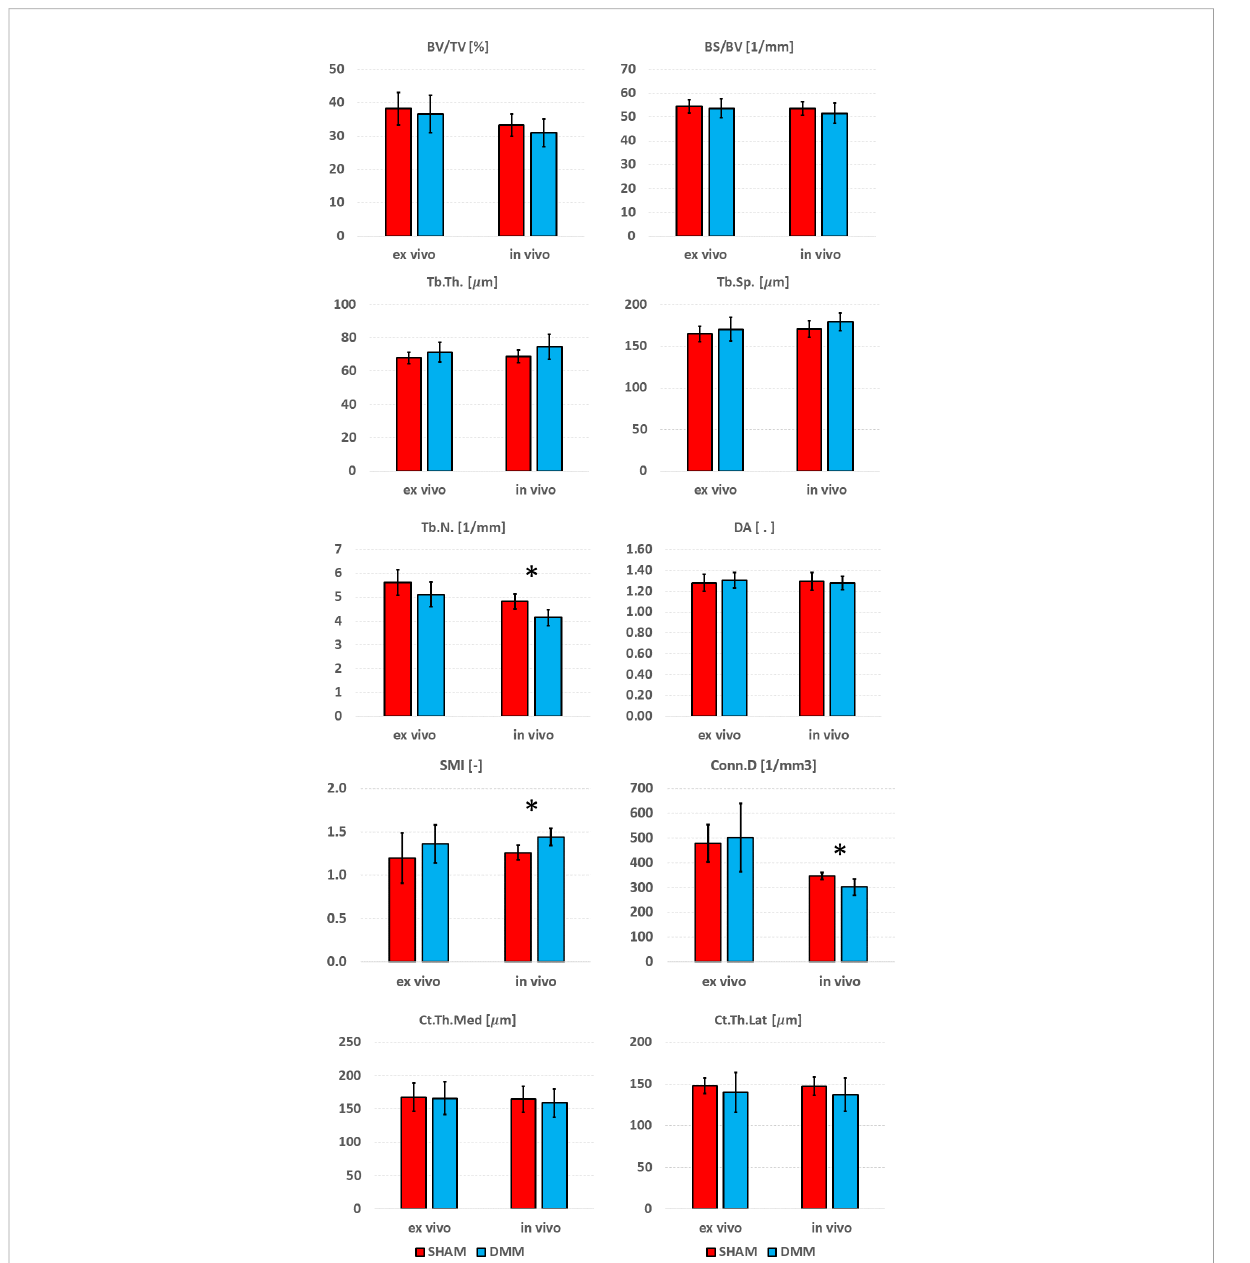
FIGURE 7 Effect of DMM surgery measured with in vivo and ex vivo microCT. Trabecular bone volume fraction (BV/TV), bone surface fraction (BS/BV), trabecular thickness (Tb.Th), trabecular separation (Tb.Sp), trabecular number (Tb.N), degree of anisotropy (DA), structure model index (SMI) and connectivity density (Conn.D), and cortical thickness (Ct.Th) at medial and lateral side. *signi fi cant differences